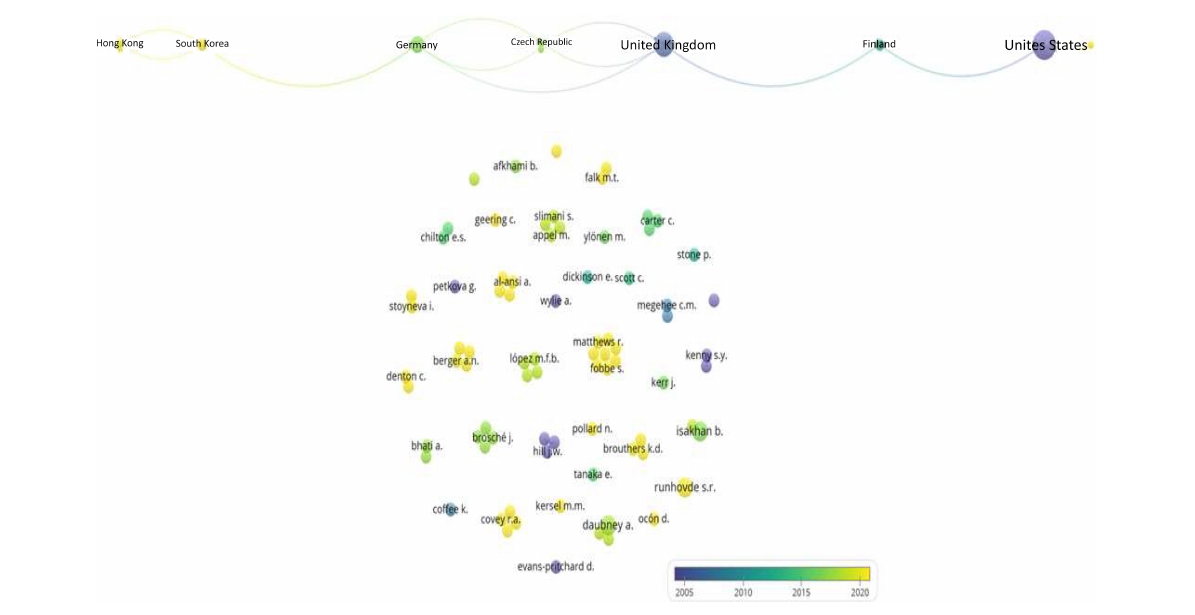
FIGURE3 Network of authors and countries of affiliation.